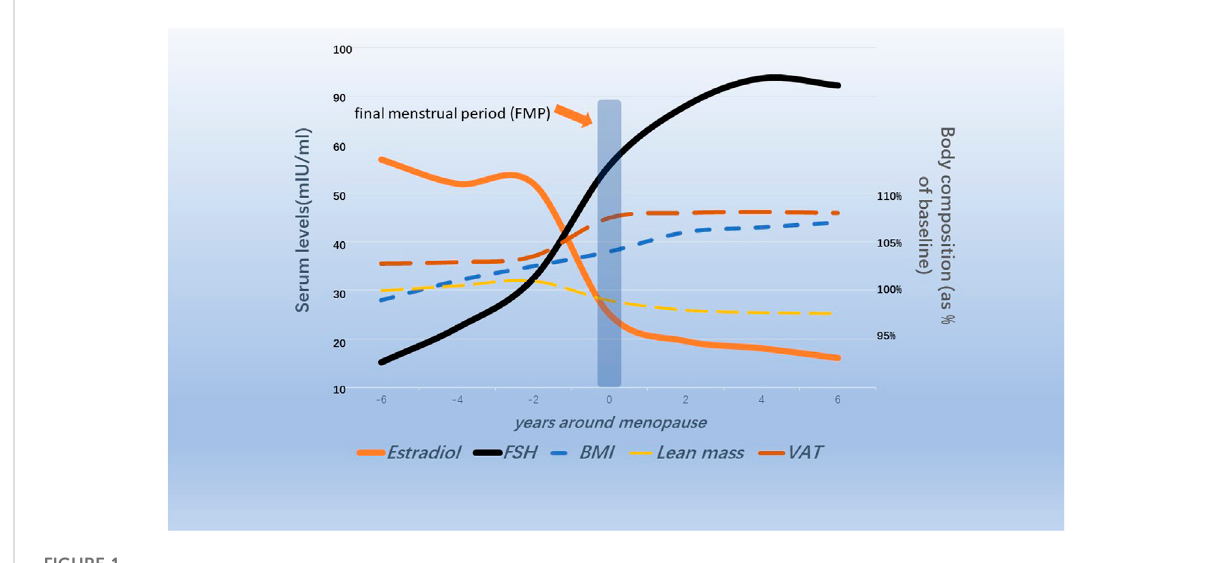
FIGURE 1 Schematic diagram of changes in ovarian hormones and body composition in menopausal transitional women (Randolph et al., 2011; Greendale et al., 2019b; Greendale et al.,